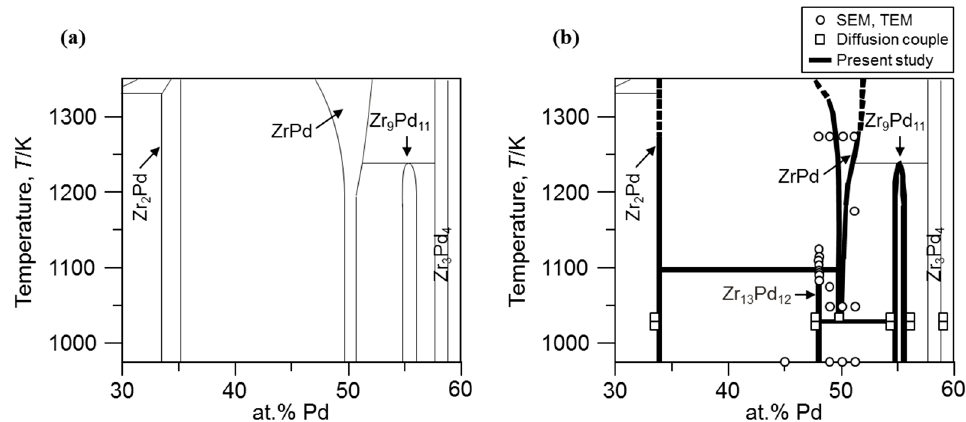
Figure 1. ( a , b ) shows the Zr-Pd binary phase diagrams evaluated by data from [5] and the summary of all the present experimental results plotted between Zr 2 Pd and Zr 3 Pd 4 compounds, respectively. Open circles indicate SEM and TEM observation, and squares are obtained from the diffusion couple experiments.